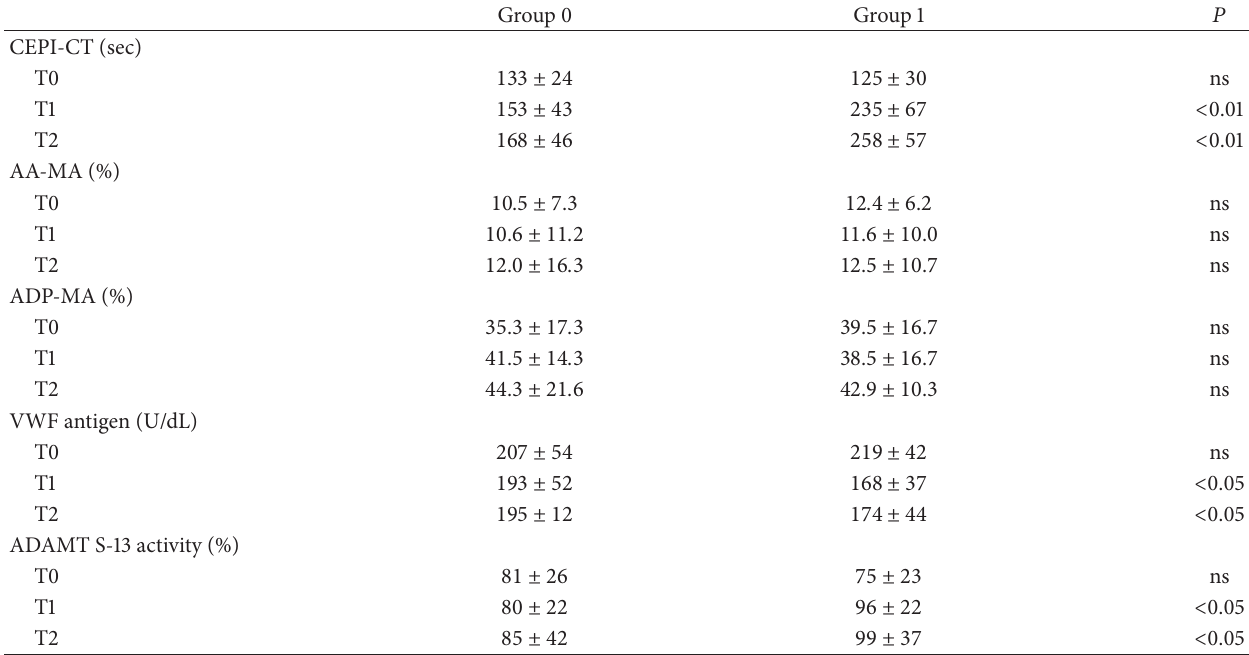
Table 2: Platelet function tests results; VWF, and ADAMTS-13 levels.